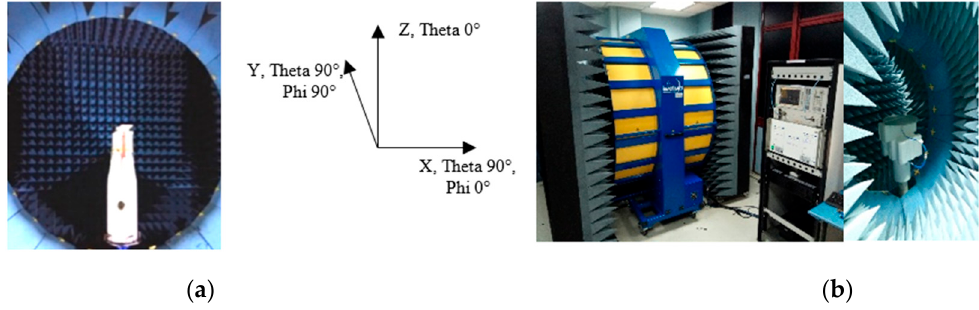
Figure 25. Measurement setup in ( a ) Satimo SG24 (350–6000 MHz measurement) and ( b ) Satimo Starlab (7000–10,000 MHz) for the radiation pattern measurement of the antenna.